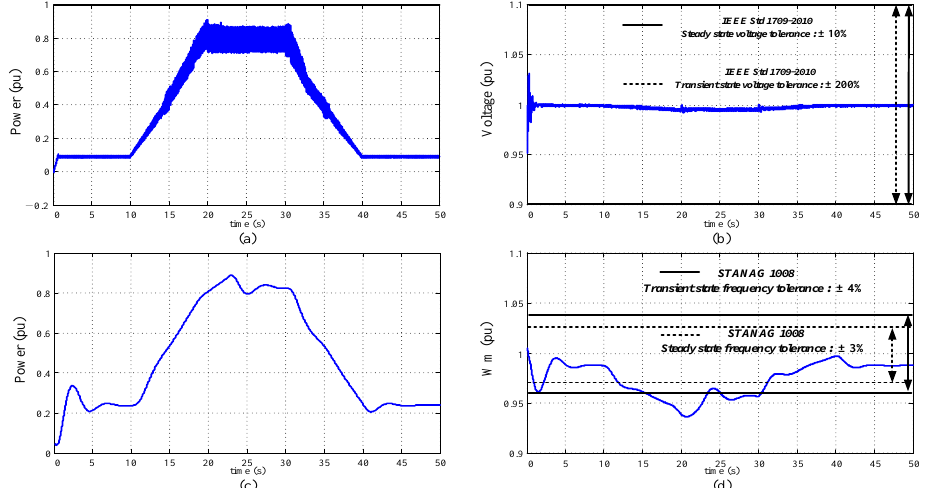
Figure 8. Simulation results of the acceleration and deceleration (without the energy storage system): ( a ) Output power of the propulsion motor; ( b ) Main DC bus voltage; ( c ) Output power of the steam turbine; ( d ) Frequency of the generator.